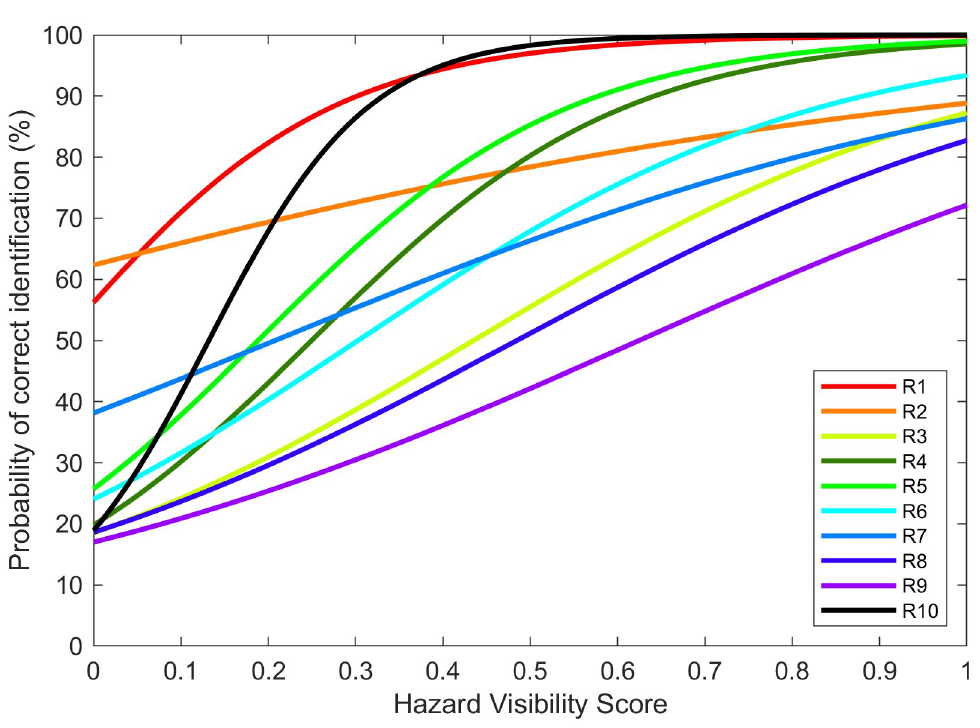
Fig 8. Logistic regression models of 10 low-vision subjects.